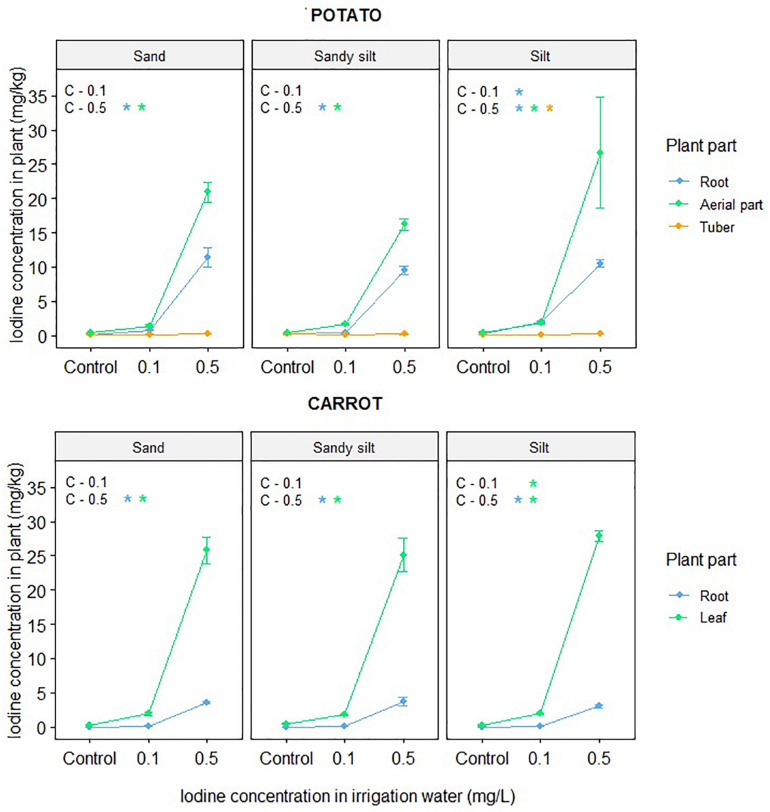
Iodine concentration in different parts of potato and carrot plants cultivated and irrigated with iodine-containing (0.1 and 0.5 mg/L) water in different soils (sand, sandy silt, and silt). Significant treatment effects are indicated on the top-left corner; *p < 0.05 based on linear regression.